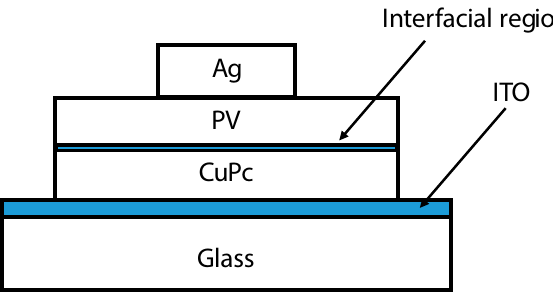
Figure 3. Schematic of Tang’s bilayer device using copper phthalo-